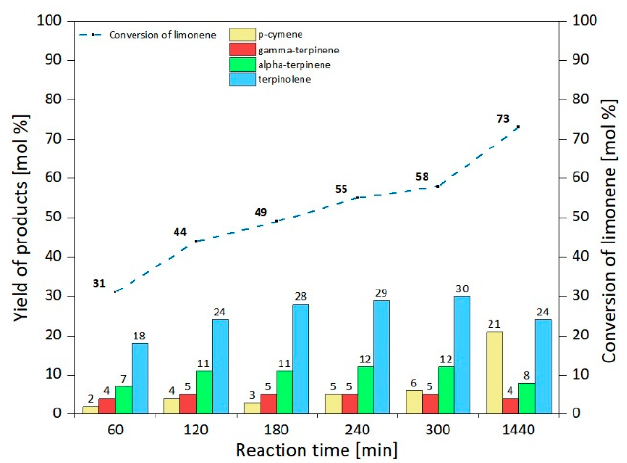
Figure 10. Influence of reaction time on the yield of products of the isomerization of limonene. Amount of the catalyst 0.75 g (15 wt% in relation to mass of limonene). The reaction was performed at 150 °C. (The experimental error was 1 mol%.)